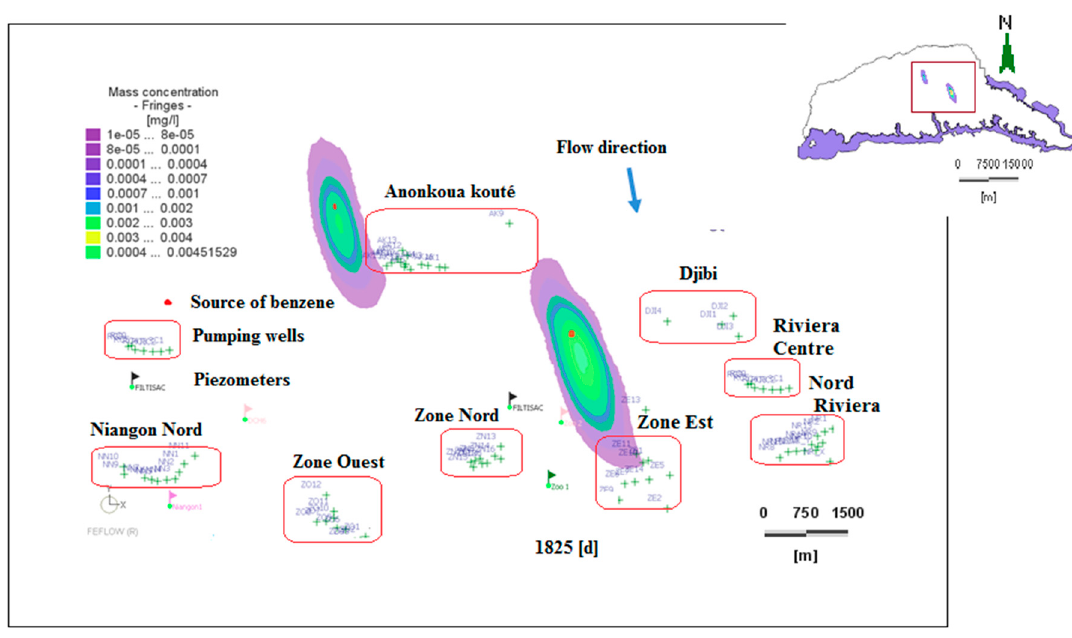
Figure 14. Dissolved benzene plume dispersion at 1825 days (1983).